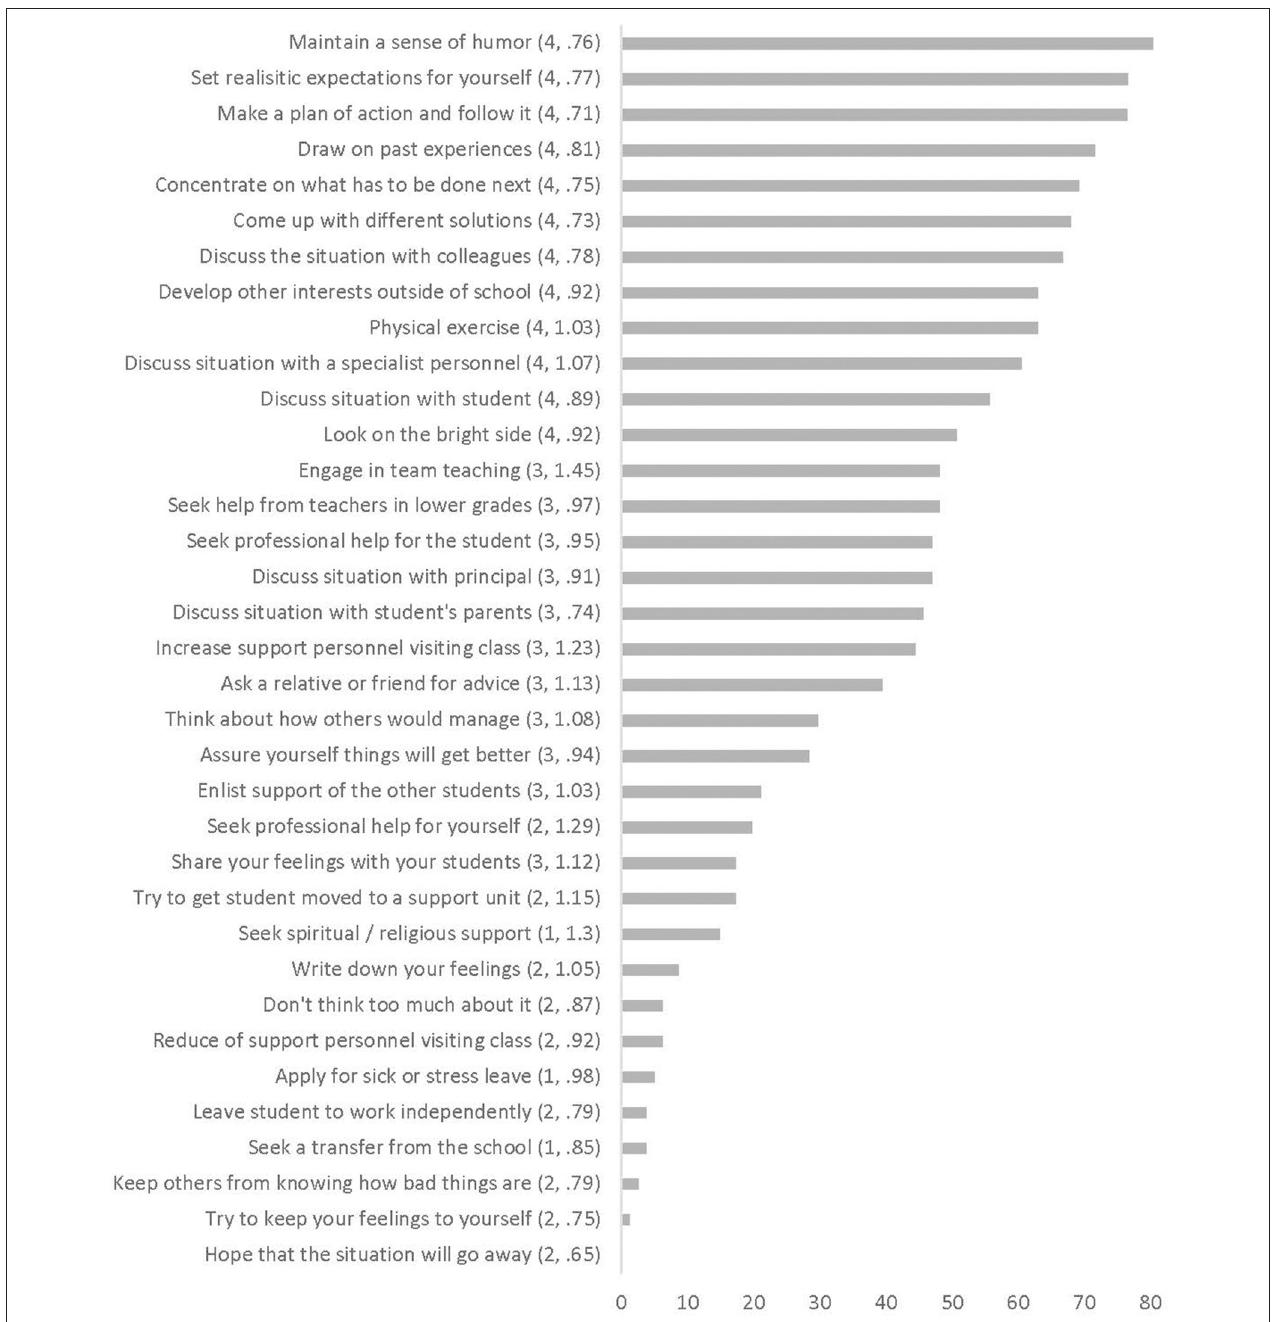
FIGURE 3 | Median and standard deviation for different coping types and bars illustrating % frequency of responses indicating “quite” (4) or “extreme” (5)